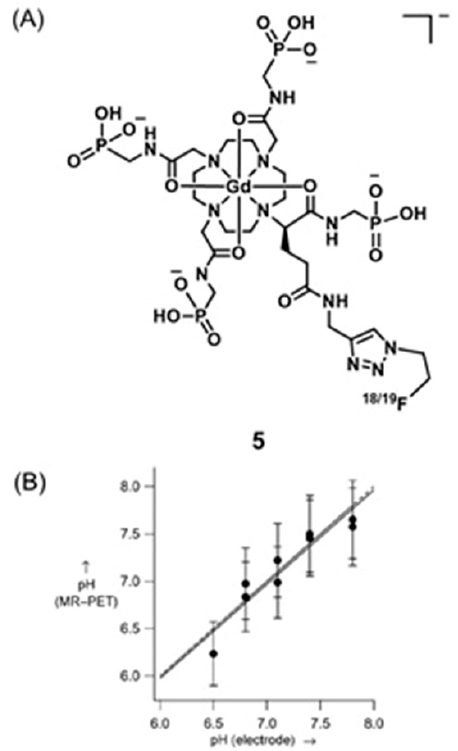
Figure 11. ( A ) Chemical structure of 5 used for dual-mode PET and 1 H-MRI for quantitative pH measurements. Phosphonates are drawn singly protonated because of the expected first (p K a ≈ 2–3) and second (p K a ≈ 7–8) p K a values. ( B ) pH determined with the MRI/PET technique versus pH determined using a glass electrode. The solid line represents a linear fit of the data, and the dashed line represents a hypothetical 1:1 correspondence between the x - and y -axes. Adapted with permission from Frullano, L.; Catana, C.; Benner, T.; Sherry, A. D.; Caravan, P. Angewandte Chemie Interna- tional Edition , John Wiley and Sons [266].